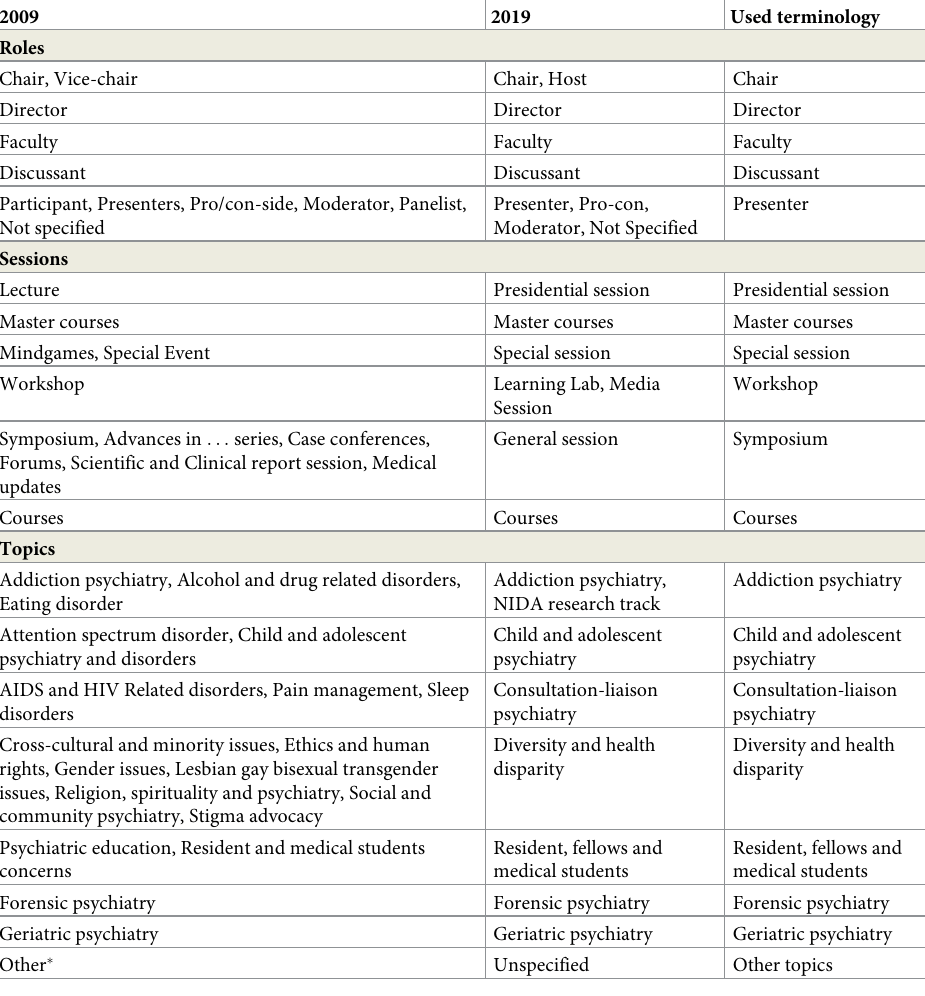
Table 1. Terminology matching between 2009 and